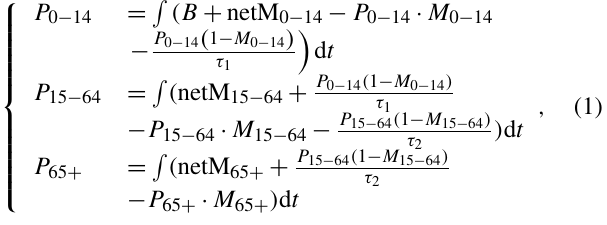
Figure 11. CLD in the fish